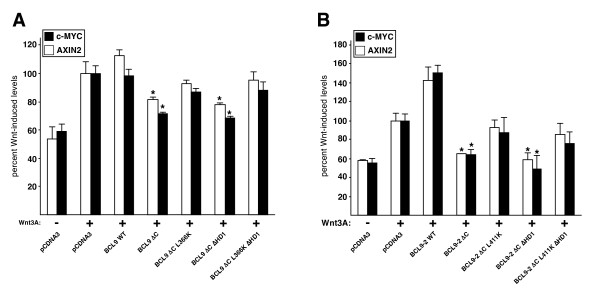
Requirement of the C-terminus of BCL9 for Wnt-induced transcription. Transcript levels of c-MYC and AXIN2, as measured by RT-qPCR, in Wnt-induced HEK 293 cells (as in Fig. 3) after overexpression of wt or mutant (A) FLAG-BCL9 or (B) FLAG-BCL9-2. Statistical significance (p < 0.01) relative to Wnt-stimulated control cells (set arbitrarily to 100%) is indicated by asterisks above bars.